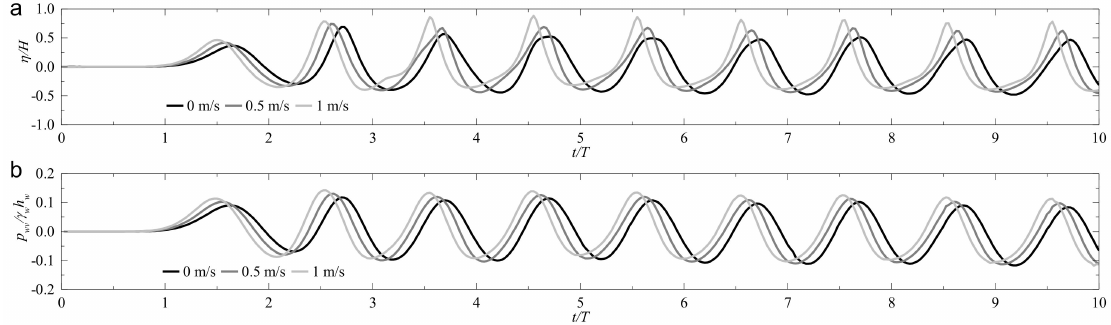
Figure 4. Time series of ( a ) free surface elevation and ( b ) wave pressure at location O for various current